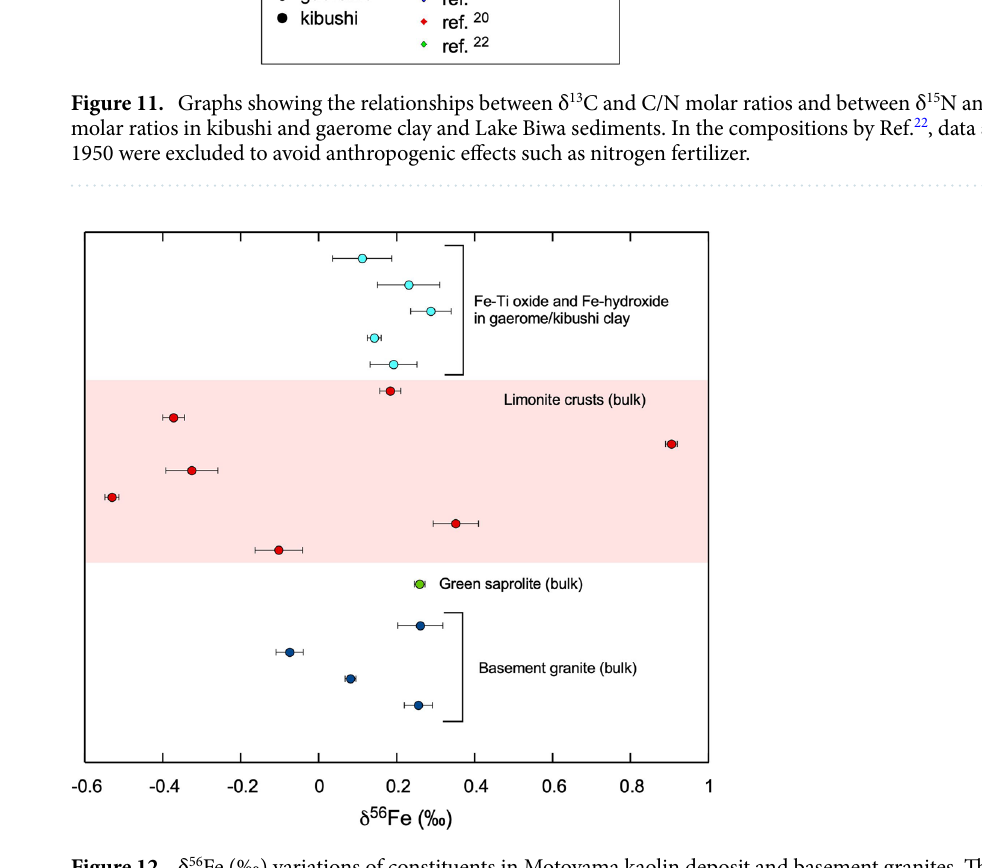
Figure 12. δ 56 Fe (‰) variations of constituents in Motoyama kaolin deposit and basement granites. The vertical axis describes the spatial relationship in Motoyama kaolin deposit. Pink indicates limonite